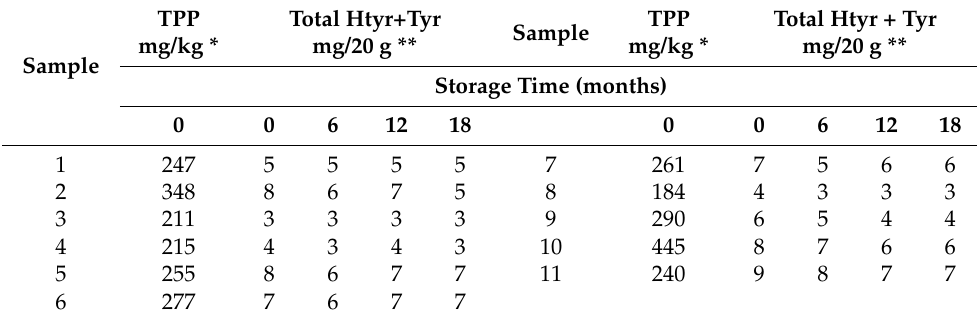
Table 3. Total hydroxytyrosol (Htyr) and tyrosol (Tyr) content and total polar phenol (TPP) content of VOO samples cv. Chondrolia Chalkidikis and Chalkidiki from the main olive mills of the regional unit of Chalkidiki during the 18-month storage in the dark at room